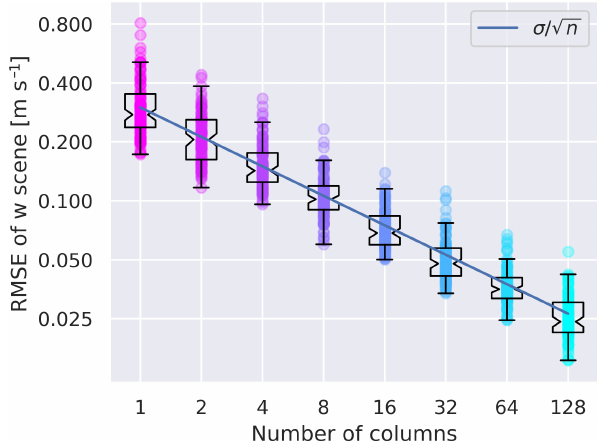
Figure 13. Root mean square error (RMSE) between two randomly sampled w scene composites. The exact process by which the sam- pling occurs is explained in Sect. 7 and is applied 100 times for each color. The x axis denotes the number of 1D column outputs included in the randomly sampled scenes. Note the logarithmic y axis. The added line marks the sampling error associated with draw- ing n samples from a normal distribution with a standard deviation of 0.3ms − 1